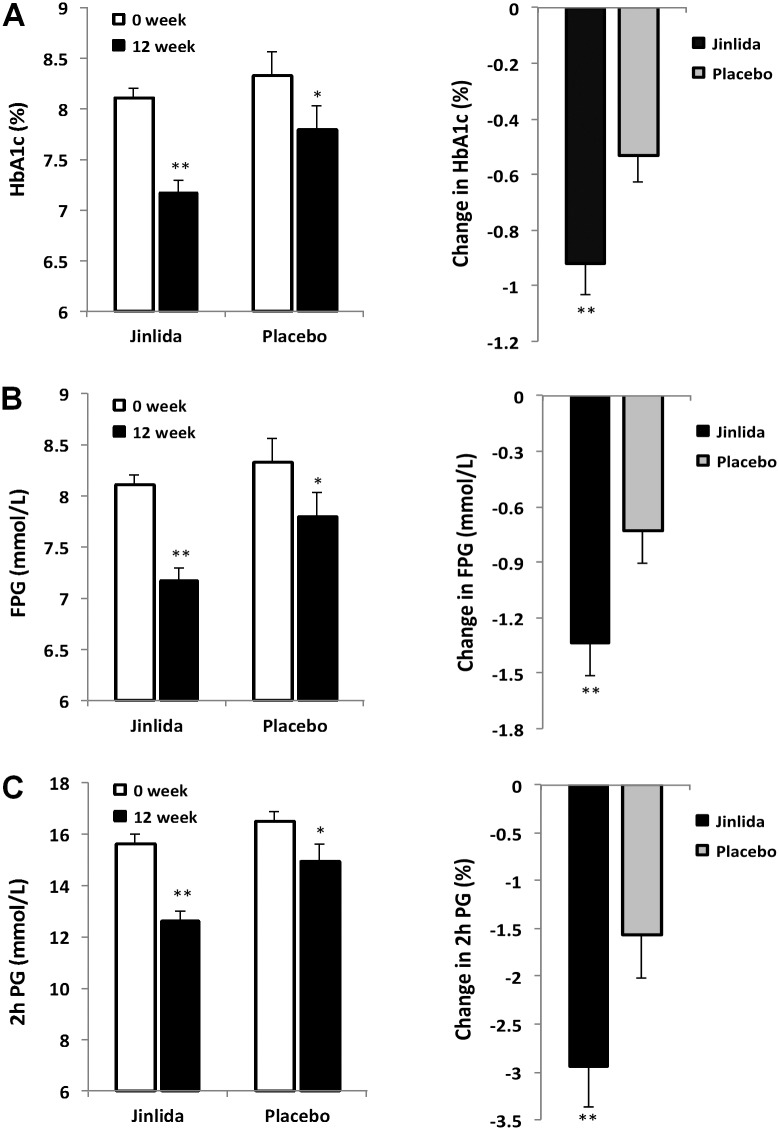
Changes in HbA1c, FPG and 2 h PG in the Jinlida group and placebo group.(A) Left: The mean HbAlc decreased significantly in both groups between the baseline and after treatment. Right: There was a very significant statistical difference in the change between the two groups at week 12. (B) Left: The mean FPG decreased significantly in both groups between the baseline and after treatment. Right: There was a very significant statistical difference in the change between the two groups at week 12. (C) Left: The mean 2 h PG decreased significantly in both groups between the baseline and after treatment. Right: There was a very significant statistical difference in the change between the two groups at week 12. Data presented as mean ± S.E. *p < 0.05. **p < 0.01.